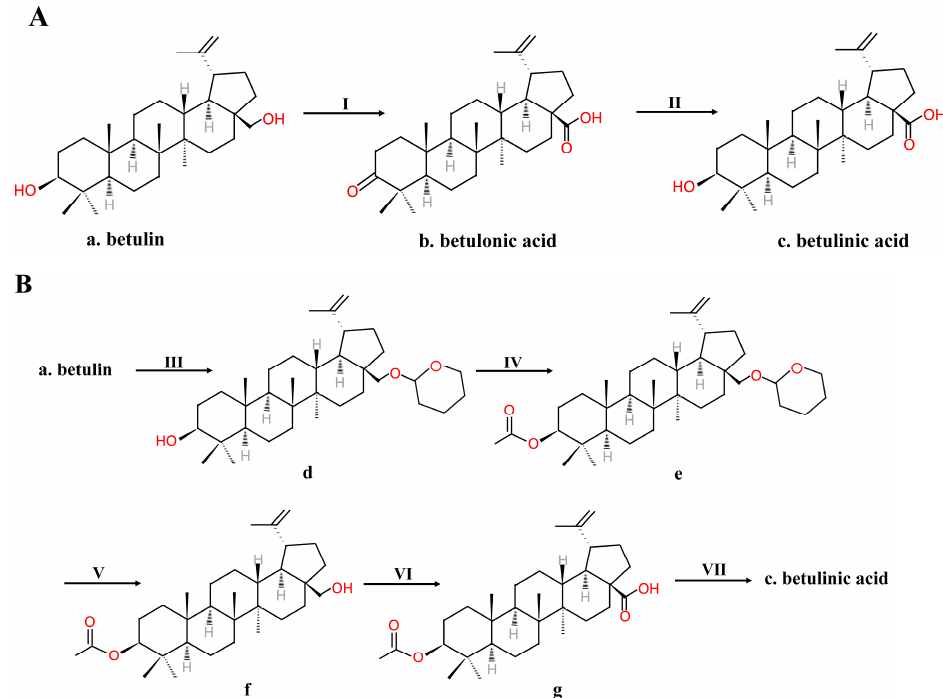
Figure 2. ( A ) Kim’s two-step method for obtaining BA from betulin. ( B ) Kim’s five-step method for